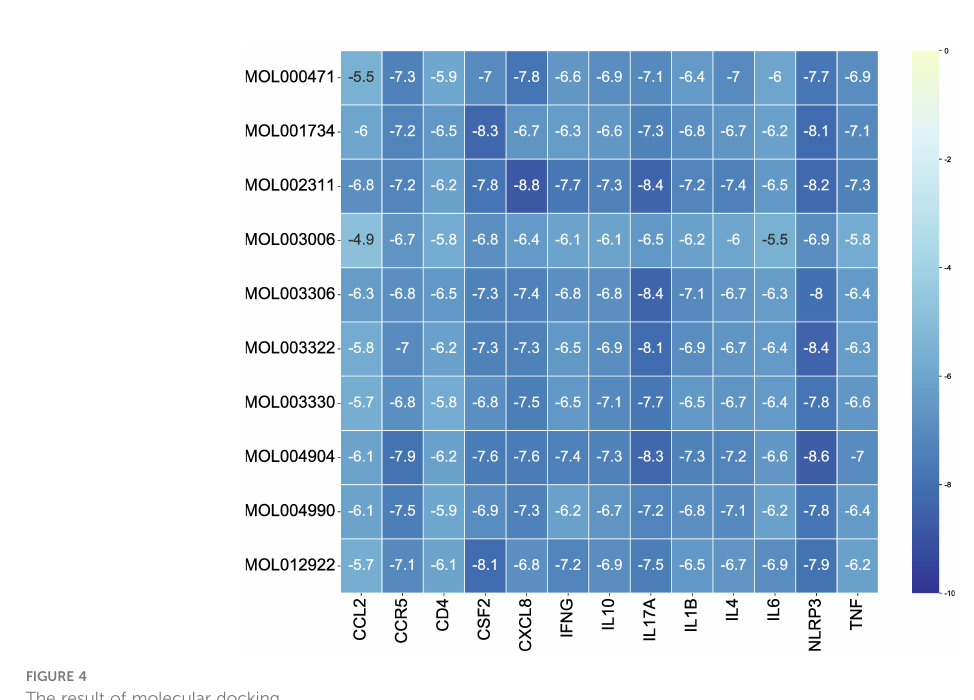
FIGURE 4 The result of molecular docking.